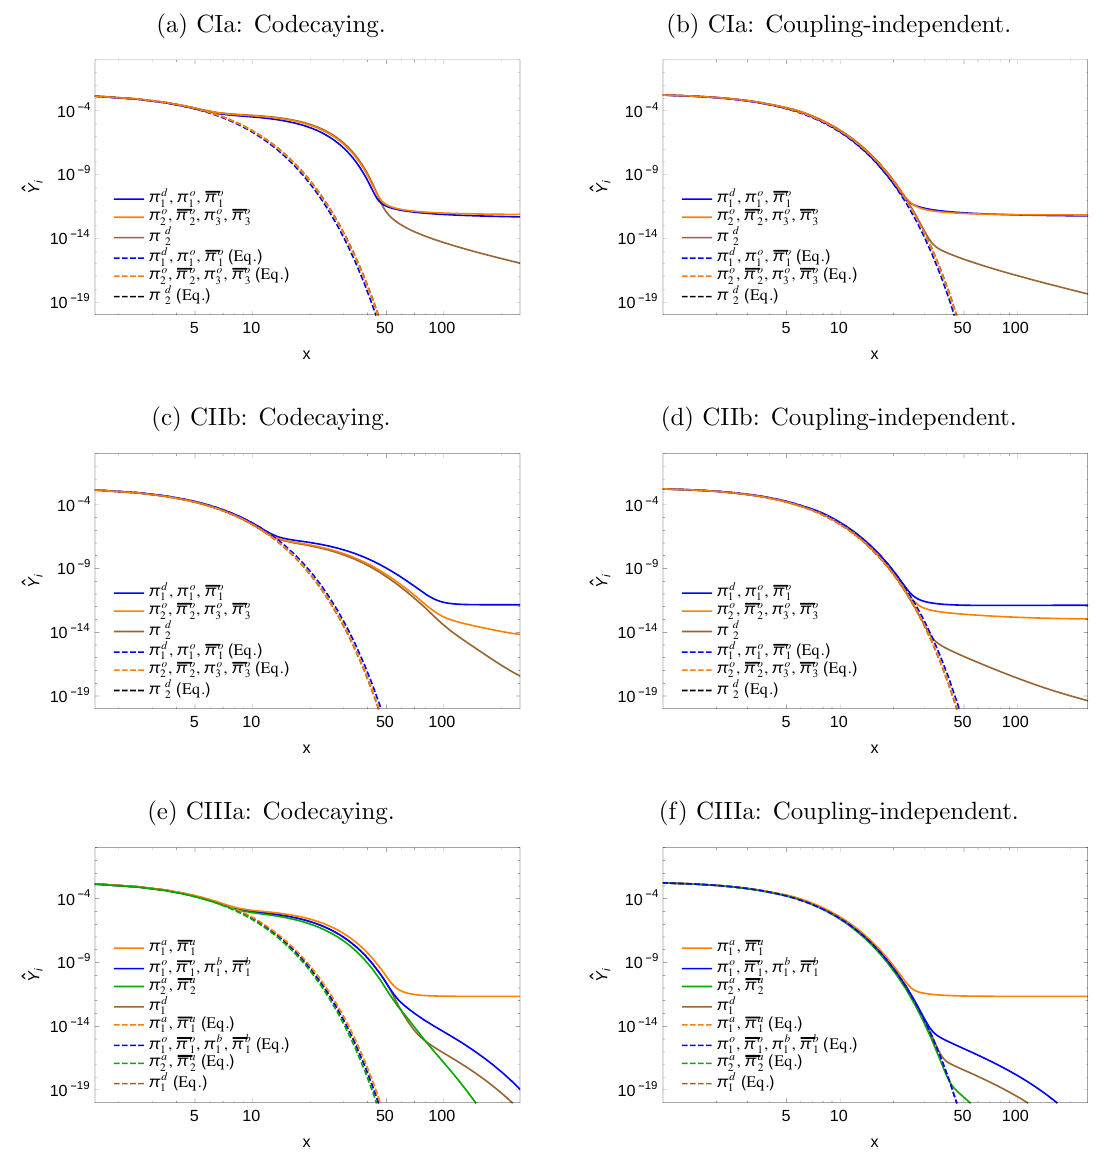
Figure 2. Examples of the cosmic evolution of the pion abundances for the di(cid:11)erent categories and regimes. For category I, the parameters are set to: m 1 =m 3 = 1 : 1, m (cid:25) s = 100 GeV and (a) 3 (cid:0) = 10 (cid:0) 16 GeV, (b) (cid:0) = 10 (cid:0) 14 GeV. For category II, the parameters are set to: m 3 =m 1 = 1 : 1, (cid:25) d 1 (cid:25) d 1 m (cid:25) s = 100 GeV and (c) (cid:0) = 10 (cid:0) 15 GeV, (d) (cid:0) = 10 (cid:0) 13 GeV. For category III, the parameters (cid:25) d 1 (cid:25) d 1 3 are set to: m 2 =m 1 = 1 : 1, m (cid:25) a = 100 GeV and (c) (cid:0) = 10 (cid:0) 16 GeV, (d) (cid:0) = 10 (cid:0) 14 GeV. In the (cid:25) d 1 (cid:25) d 1 1 last case, the decay widths of the other unstable pions are set to (cid:0) = 10. In all cases, the pion (cid:25) d 1 decay constant is adjusted to reproduce the correct DM abundance. The number of colors N c is set to 3 for CIa and CIIb and to 4 for CIIIa. See sections 5 and B.1 for the notation.